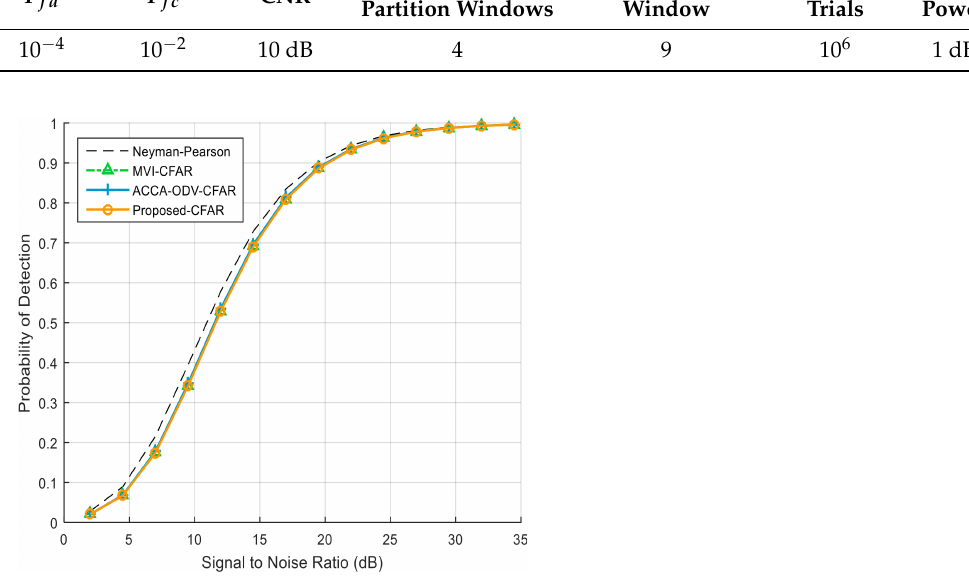
Figure 6. Detection probability in homogeneous environment ( N = 36; P fa = 10 − 4